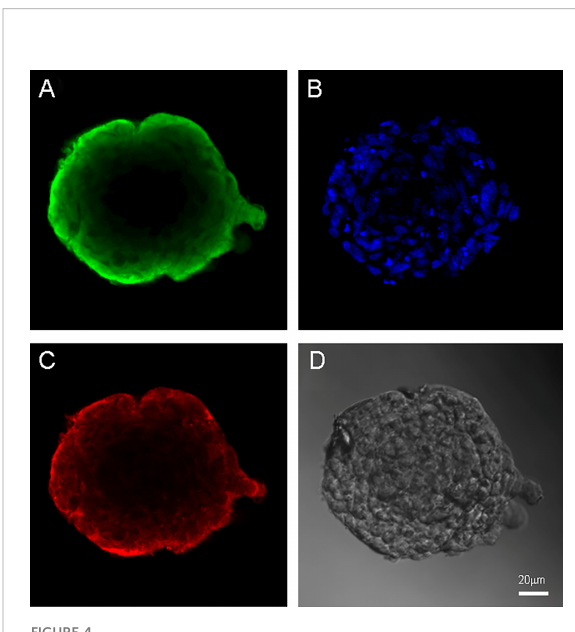
FIGURE 4 Neurospheres of glioblastoma cell culture of Sus\fP2. (A) antibody staining for Vimentin. (B) staining for bisbenzimid, (C) antibody staining for Nestin, (D) neurospheres in phase contrast. Scale bar is 20 m m.